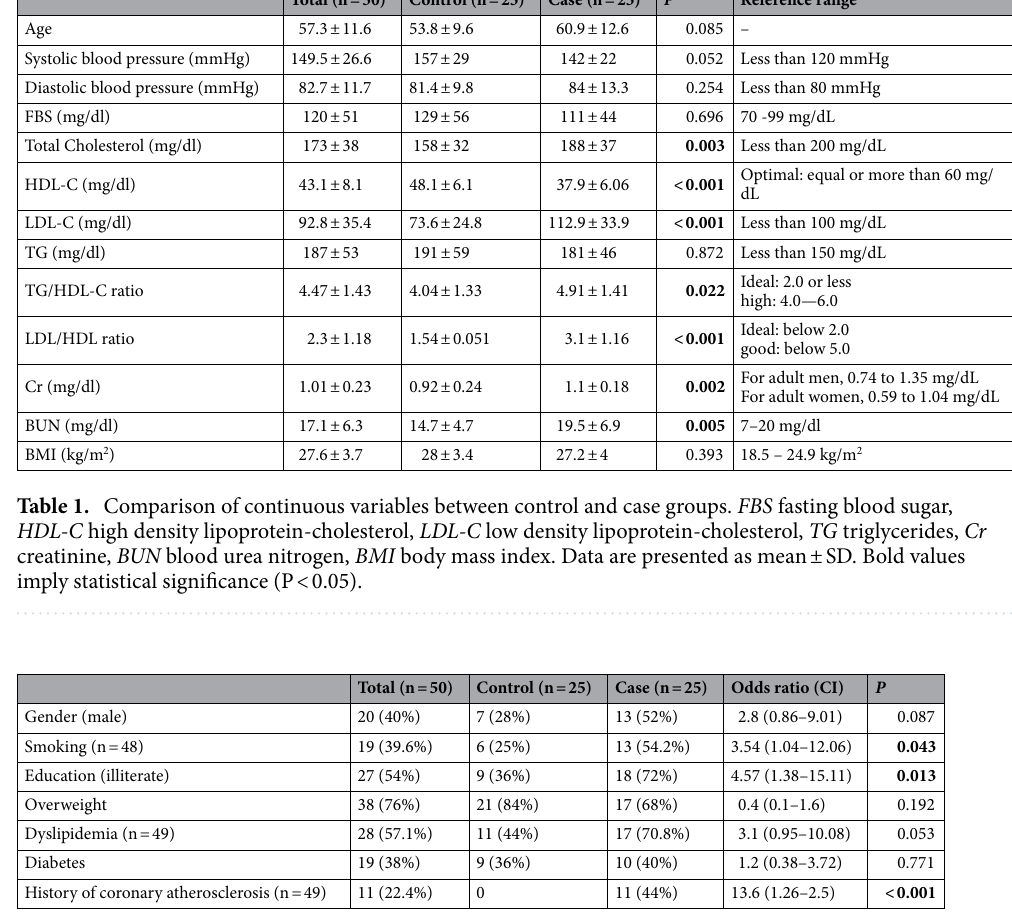
Table 2. Comparison of categorical variables between control and case groups. CI confidence interval: Data are presented in numbers (%). Bold values imply statistical significance (P < 0.05).